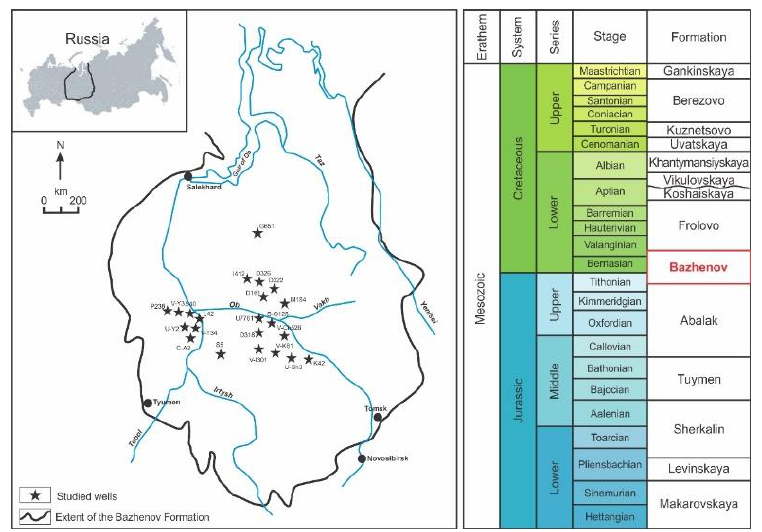
Figure 1. Map of the Bazhenov Formation with studied wells where the alginite-rich layers have been discovered ( left ) and stratigraphy of Mesozoic deposits of Western Siberia ( right ), modified from [12].